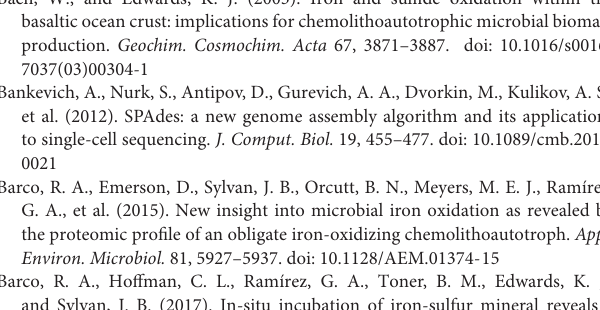
Supplementary Figure 1 | Cryptic iron cycling on the surface of an olivine mineral incubated within the Juan de Fuca aquifer (borehole 1301A). The green trapezoid represents the olivine mineral with the chemical formula (Mg 2 + , Fe 2 + ) 2 SiO 4 . Oxidation of reduced iron within the olivine mineral by iron-oxidizing bacteria (FeOB) results in the formation of iron(III) oxyhydroxides, and chemical formula Fe(OH) 3 , a by-product of microbial iron oxidation. The iron oxyhydroxides can then be used as terminal electron acceptors by iron-reducing bacteria (FeRB), releasing reduced iron from the mineral. Cyc2 and GACE_1847 are shown as putative iron oxidases and iron reductases, respectively, in this